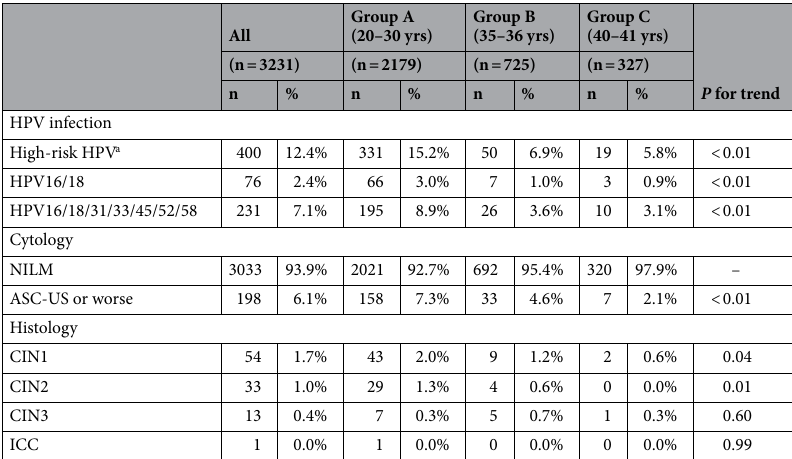
Table 2. Prevalence of HPV infection, abnormal cervical cytology and histology. a HPV16/18/31/33/35/39/45/51/52/56/58/59/68 (HC2).